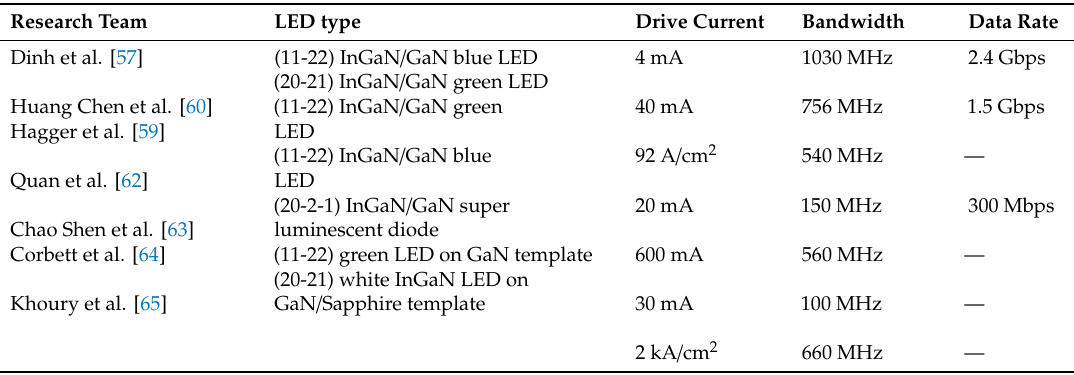
Table 1. Summary of the reported device performance of the semipolar LED-based Visible Light Communication (VLC)